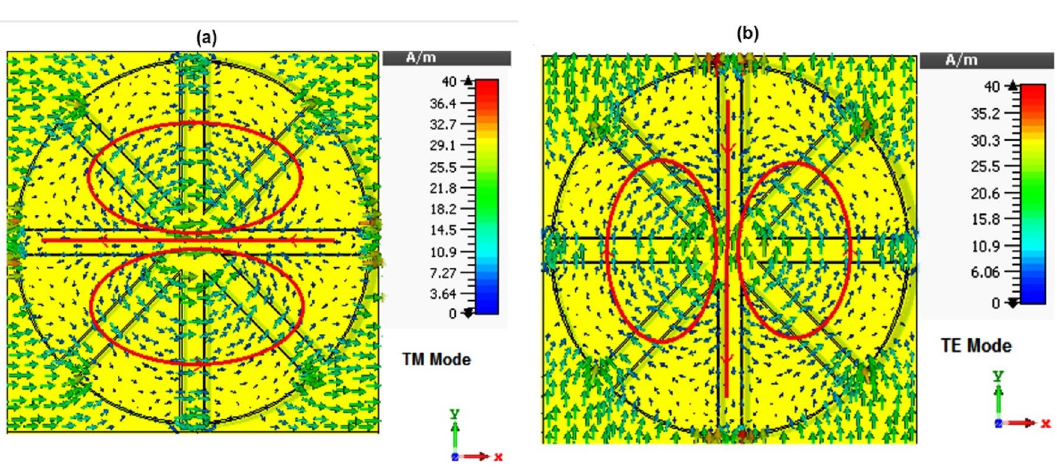
Figure 7. The surface current distribution at the central frequency (220 GHz) for ( a ) TM and ( b ) TE